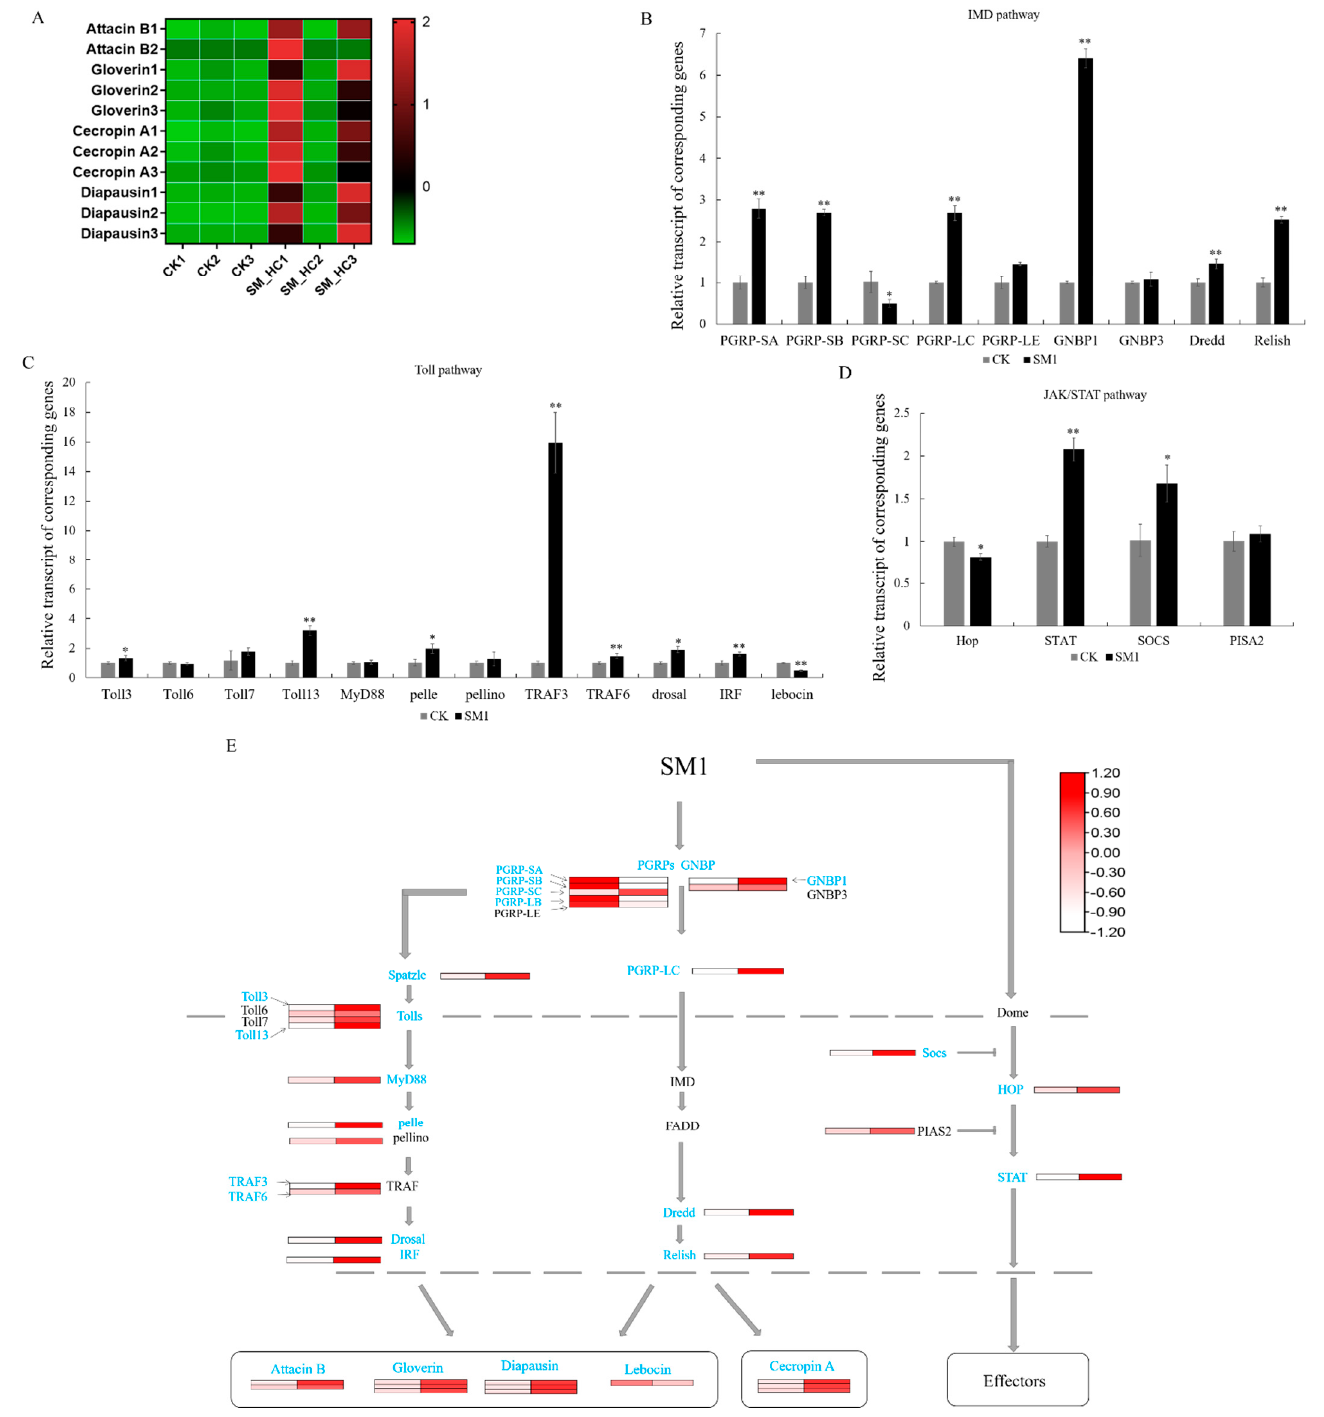
Figure 3. Changes in regulatory patterns of the Toll, IMD and JAK/STAT pathways in H. cunea infected by SM1. ( A ) Heatmap clarifying the differences in AMP genes in the Toll/IMD pathway using transcriptome data. CK1, CK2 and CK3: the control groups; SM-HC1, SM-HC2 and SM-HC3: H. cunea groups infected with SM1. ( B ) The expression profile of genes in the IMD signal transduction pathway using RT-qPCR. ( C ) The expression profile of genes in the Toll signal transduction pathway using RT-qPCR. ( D ) The expression profile of genes in the JAK/STAT signal transduction pathway using RT-qPCR. ( E ) The immune regulation diagrammatic sketch of the Toll, IMD and JAK/STAT pathways in H. cunea integrated the results in ( A – D ). Significantly differentially expressed genes are shown in blue. p < 0.05 (*) was considered significant, and p < 0.01 (**) was considered very significant.